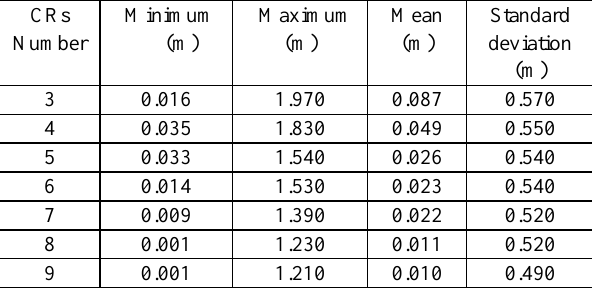
Table 1. DEM accuracy evaluation using calibration parameters derived by different number of CRs in experimental